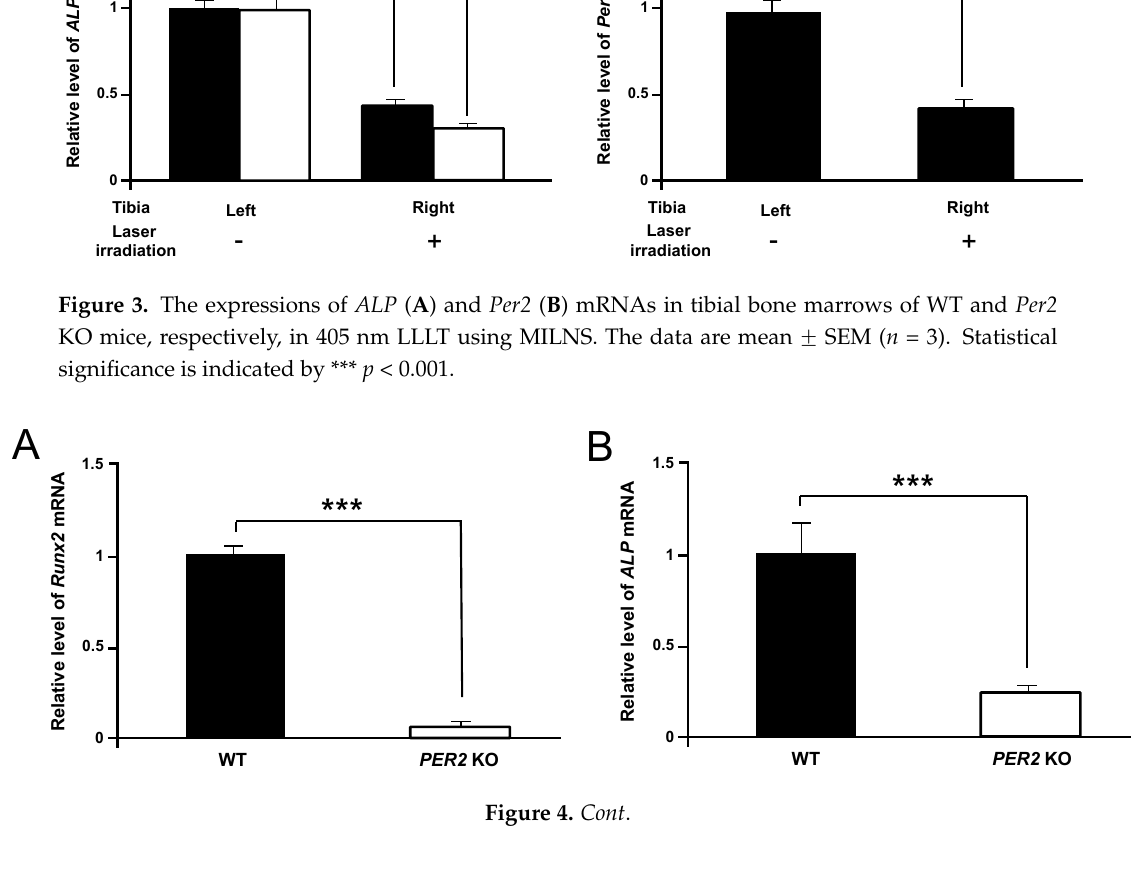
Figure 2. ( A ) Representative longitudinal 3D micro-CT images showing changes in right trabecular bone microarchitecture regions of interest in 405 nm LLLT using MILNS in WT and Per2 KO mice: ( A ) a and d , 0 weeks; b and e , two weeks; and c and f , four weeks. The tibia was directly irradiated with LLLT using the MILNS (405 nm, 5 mW, 3 J/cm 2 , 600 s). Mice were irradiated five days/week for four weeks. Scale bar, 0.5 mm; At 0, two, and four weeks after laser irradiation, total bone volume (mm 3 ) ( B ) and bone mineral density (g/cm 3 ) ( C ) were measured on two-dimensional images obtained using CT-AN 1.8. Data are expressed as mean ± SEM ( n = 9) and were subjected to statistical analysis, * p < 0.05; *** p < 0.001. 1.5 RNA ***